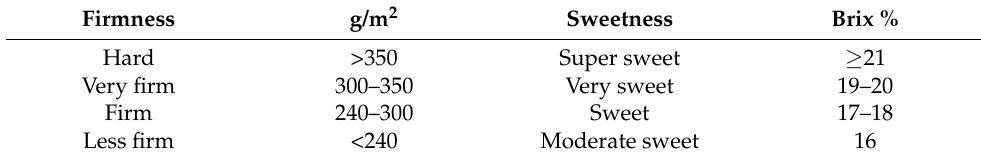
Figure 2. Australian commercial cherry size (24, 26, 28 mm in diameter). Table 1. Sweet cherry traits of firmness and sweetness in commercial production